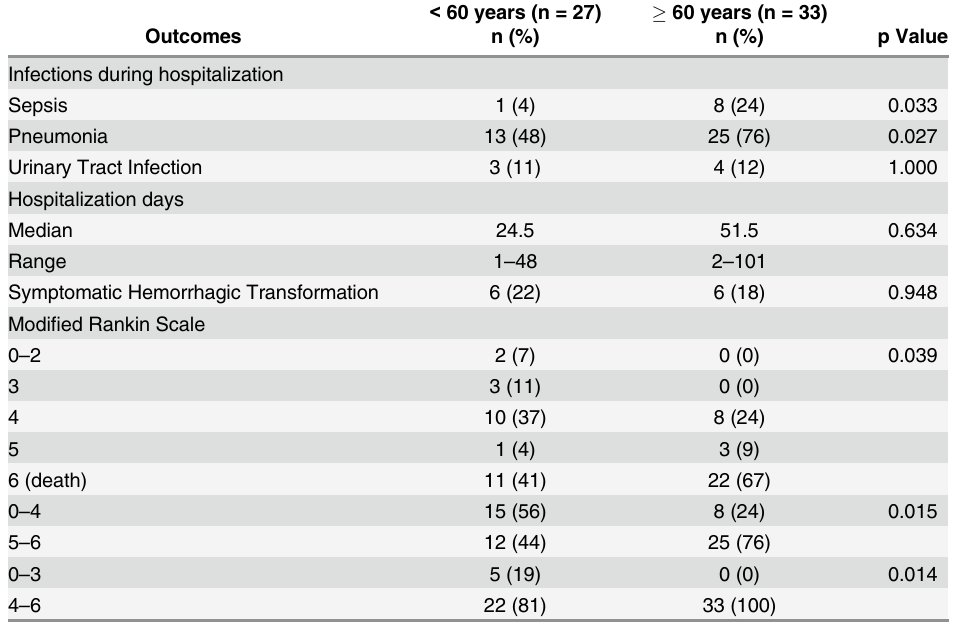
Table 4. Primary and secondary outcomes of < 60 years and (cid:1) 60 years patients after decompressive